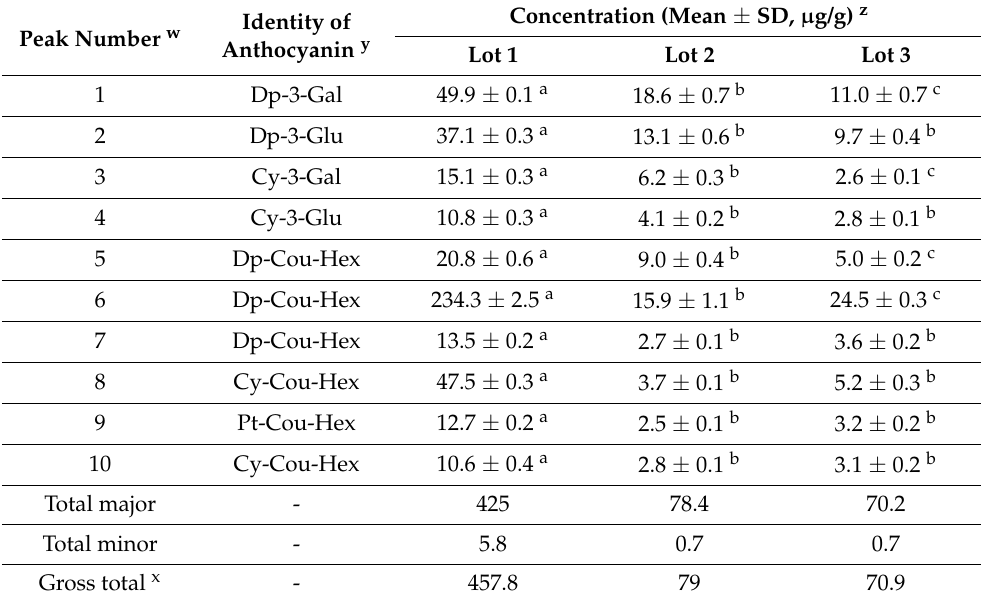
Table 3. Concentration of major anthocyanin pigments in purple tea